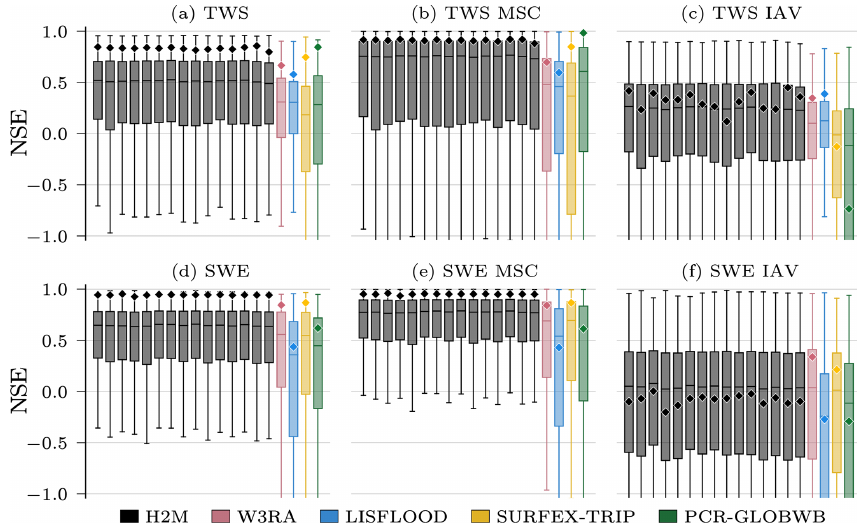
Figure 3. Global and local grid cell level Nash–Sutcliffe model efficiency coefficient (NSE) of the hybrid hydrological model (H2M) and the process-based global hydrological models (GHMs) for the terrestrial water storage (TWS) on top and the snow water equivalent (SWE) at the bottom. The gray bars represent individual cross-validation runs. The (cid:5) markers show the global (spatially averaged signal) model performance, and the boxes represent the spatial variability of the local cell level performance. The y axis was cut at − 1 due to some large negative NSE values. The panels show the model performance with respect to the full time series, the mean seasonal cycle (MSC), and the interannual variability (IAV). Note that, for SWE, only grid cells with at least 1d of snow are shown, as the NSE is not defined if the observations are constant zero, which would lead to a comparison of different grid cells. The metrics are calculated from the complete common time range from 2009 to 2012 on a monthly timescale. Note that deviations from the numbers reported in Table 3 are due to different time ranges.